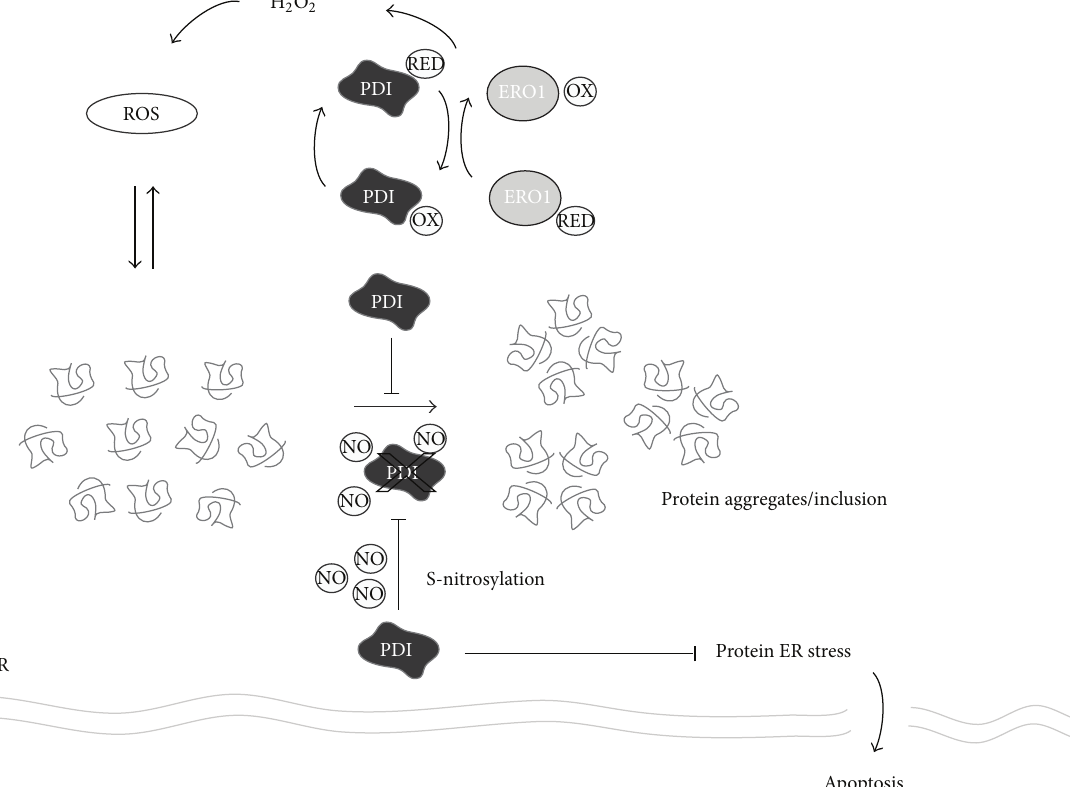
Figure 3: Possible role of protein disulfide isomerases (PDIs) in ALS. PDIs are up-regulated in diverse models of ALS in addition to tissue from patients. They also have been suggested as possible biomarkers to monitor disease progression using body fluids. PDIA1, in the figure PDI, colocalized with protein inclusions containing FUS, TDP43 or SOD1 in human tissue and mouse models of ALS. The exact contribution of PDIs to ALS is currently a matter of debate. PDIs could have a protective role through decreasing protein aggregation and global ER stress. S-nitrosylation appears to inactivate PDI and contribute to ER stress. Reactive oxygen species (ROS) produced from redox folding (disulfide bond formation) may also contribute to the generation of protein